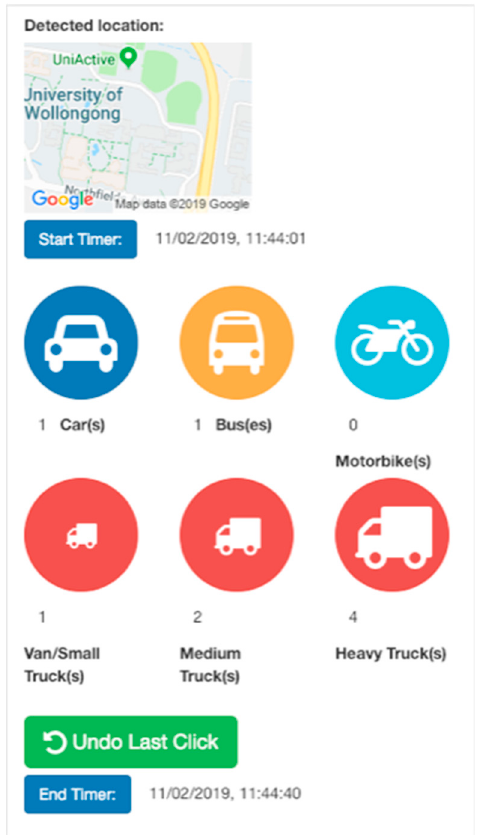
Figure 3. SMART Traffic Counter app, showing (from top left down): map of user’s location, ‘start’ timer button, buttons for counting vehicles (with running totals displayed beneath), ‘undo’ button to correct erroneous counts, ‘end’ timer button, fields for operator name and notes, ‘save’ button, and table displaying saved counts.